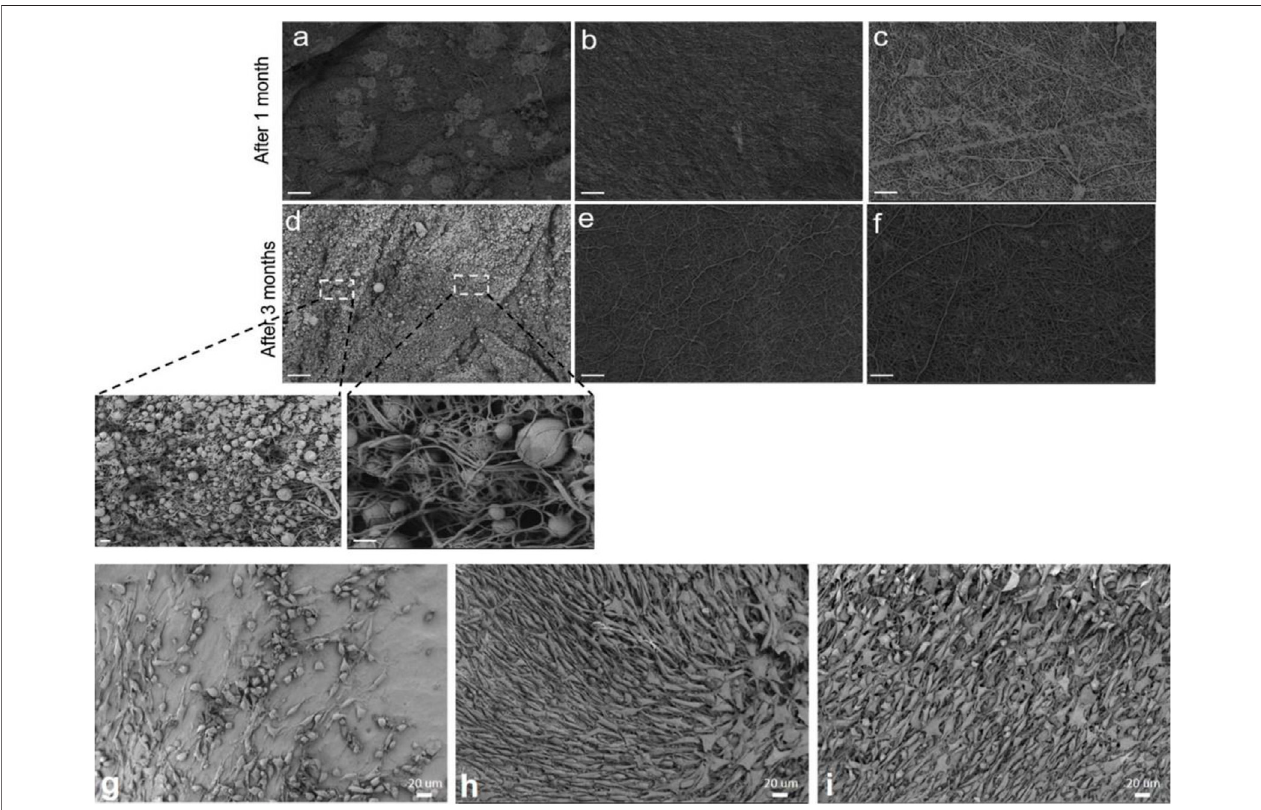
FIGURE 4 | Time dependent hydrolytic degradation process in PBS visualized by SEM images for: PCL nano fi bers (A,D) , 1 wt% BSA/PCL nano fi bers (B,E) , and 3 wt% BSA/PCL nano fi bers (C,F) (scale bars (A – F) 20 μ m and inset images of (D) 1 μ m (right) and 3 μ m (left)). SEM images represent the NIH 3T3 cell population cultured on: (G) PCL nano fi bers, (H) 1 wt% BSA/PCL nano fi bers, and (I) 3 wt% BSA/PCL nano fi bers, after 4 days. Reproduced with permission. (Homaeigohar et al., 2021a), Copyright 2021, Elsevier.